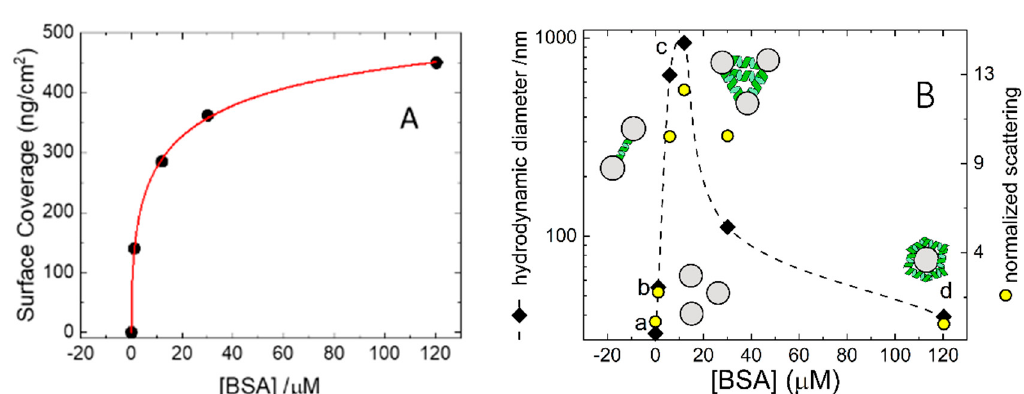
Figure 2. Interaction of BSA with a flat SiO 2 surface. ( A ) Flat surface: calculated surface coverage from the SPR sensogram shown in Figure 1 fitted with Equations (4) and (6); best fit parameters are K = (6 ± 2) × 10 4 M − 1 , m a Q = 620 ± 40 ng / cm 2 , n = 0.48 ± 0.03. ( B ) Curved colloidal surface: hydrodynamic diameters (left ordinate) and normalized scattering intensities (right ordinate) for SiO 2 nanoparticles as a function of BSA concentration measured by means of dynamic light scattering (DLS). The curves correspond to: ( a ) ludox only, ( b ) [BSA] = 1.2 μ M, ( c ) [BSA] = 12 μ M, ( d ) [BSA] = 120 μ M.